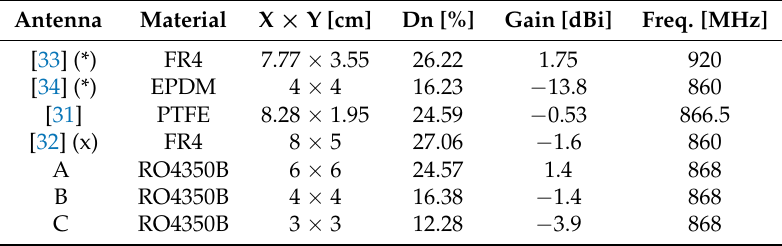
Table 3. Comparison of different published antennas. Publications marked with an asterisk (*) did not directly measure the antenna gain and publications marked with a cross (x) only included simulations of the